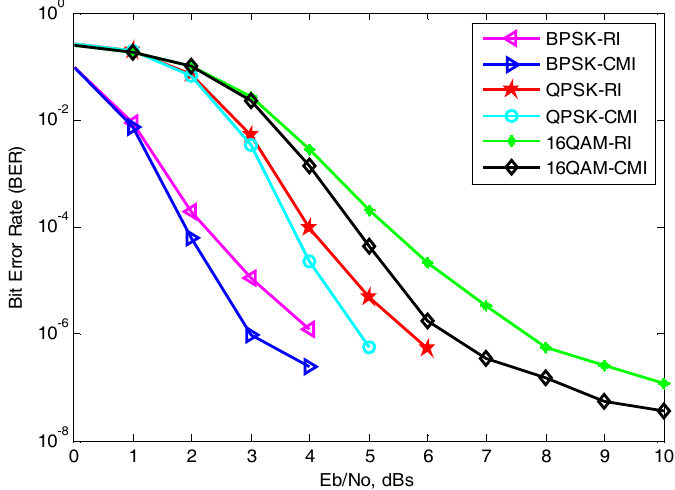
Figure 7 . BER performance of turbo coded OFDM in AWGN channel, L = 256 and four decoding iterations.